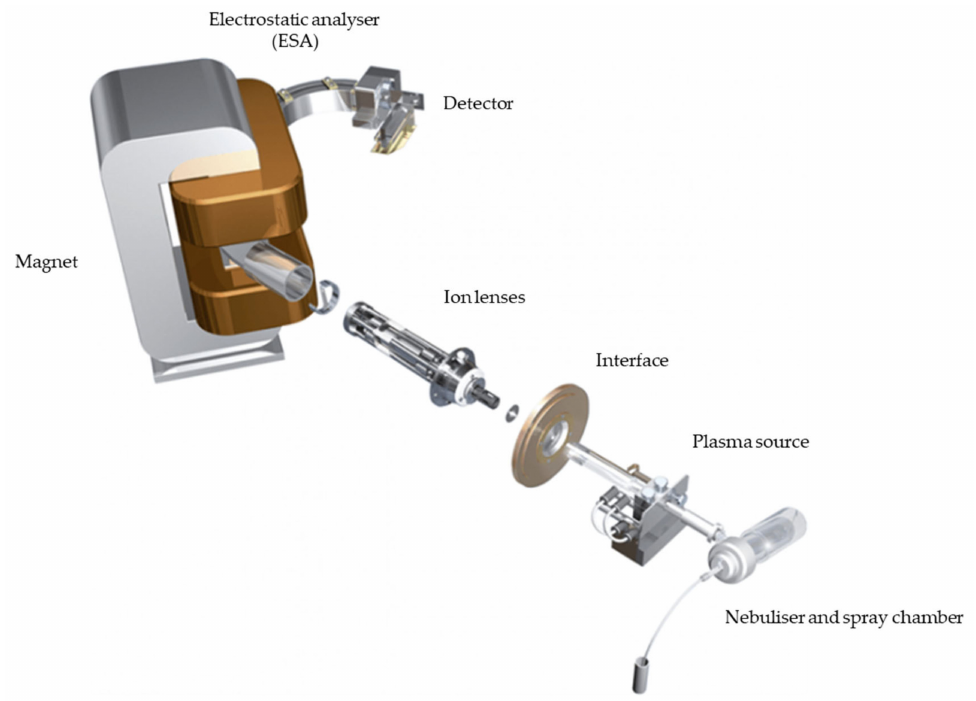
Figure 15. Scheme of Element 2 high-resolution double-focusing ICP-MS (Thermo Fischer